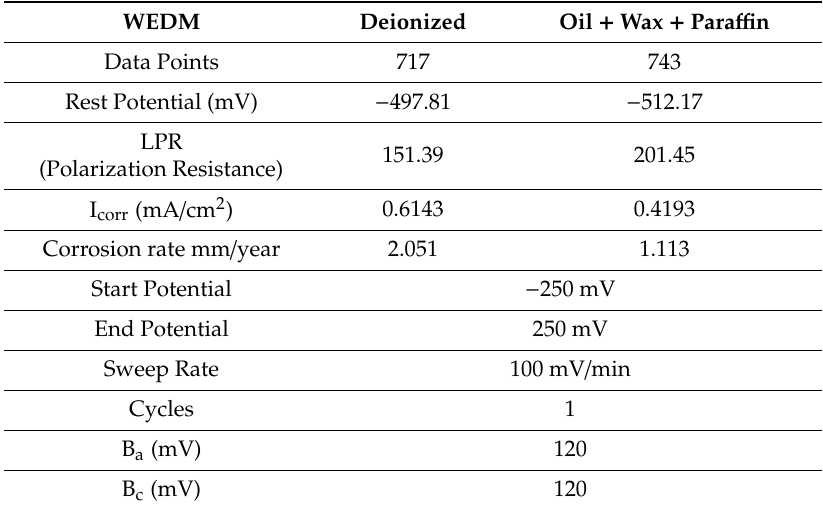
Table 14. Corrosion data recording for the wire electrical discharge machined Al-SiC-TiC metal